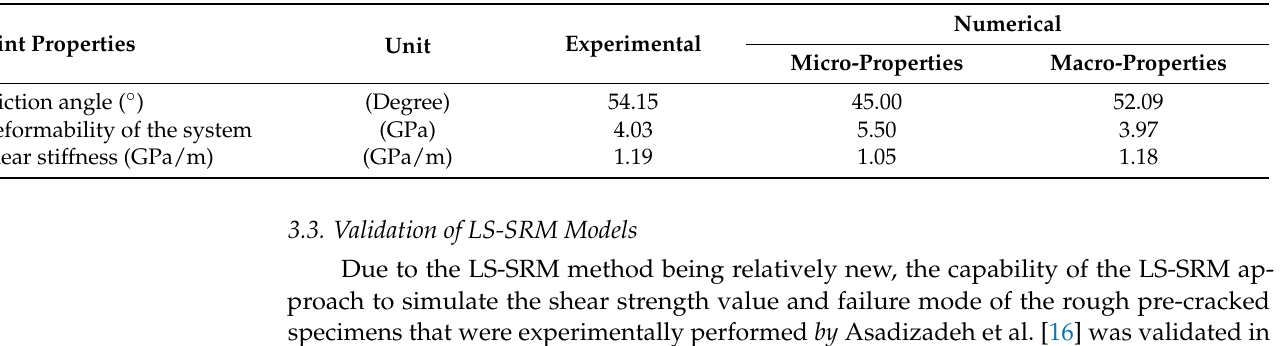
( b ) the direct shear test.